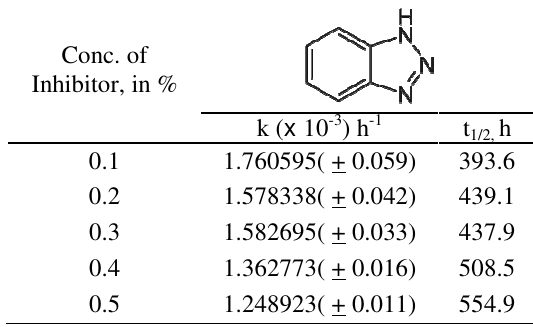
Table 2. Rate of constant (k) and half-life values for the corrosion of mild steel at different immersion times in 1 N citric acid solution in absence and presence of inhibitors of different concentration at